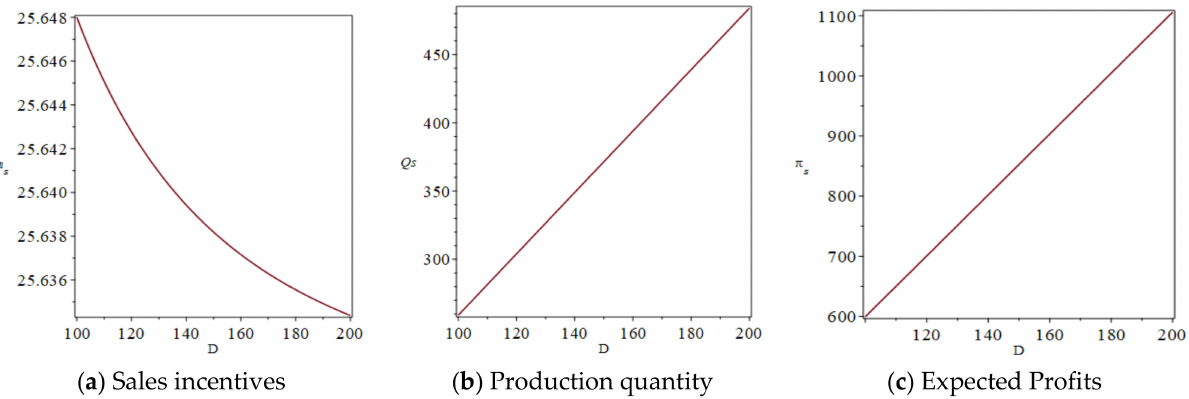
Figure 3. Impact of demand forecast values on optimal sales incentives, production quantity, and expected